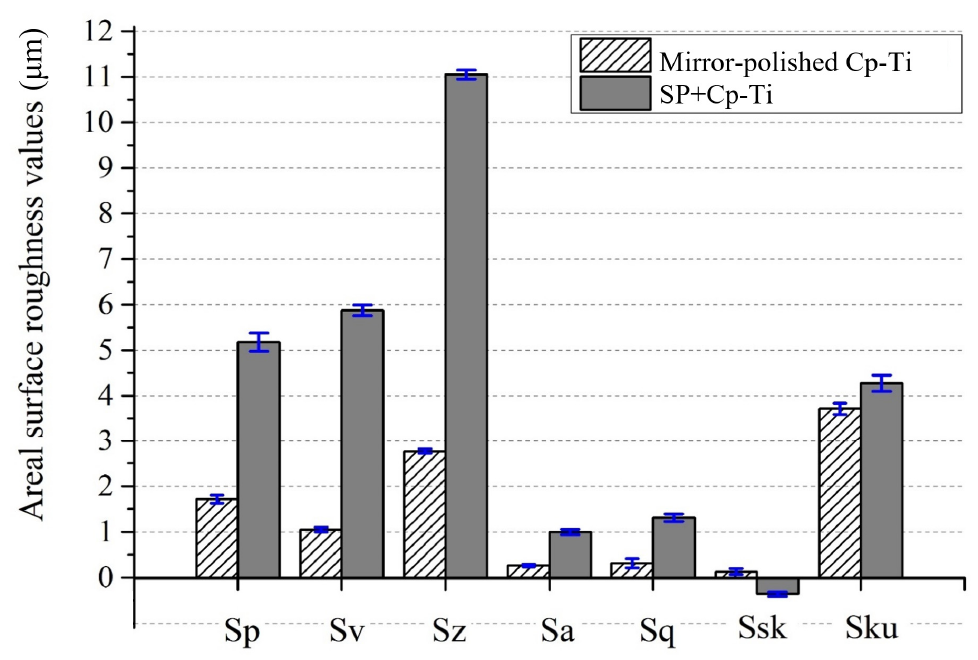
Figure 5. Areal surface roughness for unpeened (mirror-polished Cp-Ti) and shot-peened (SP Cp- Ti) surfaces.